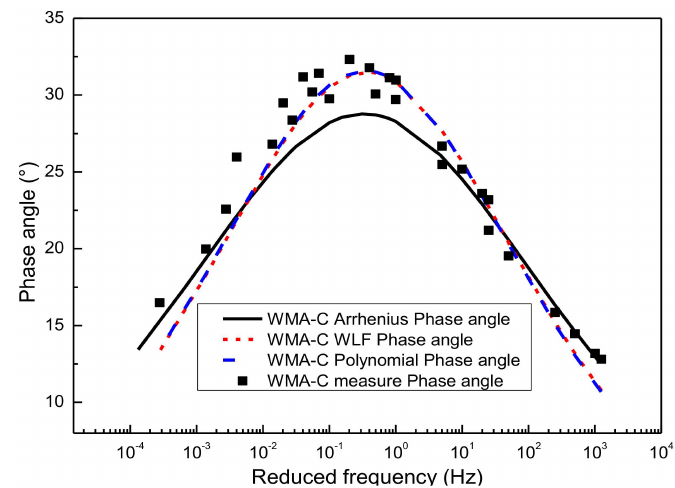
Figure 12. Predict phase angle master curve of WMA-C from SM.